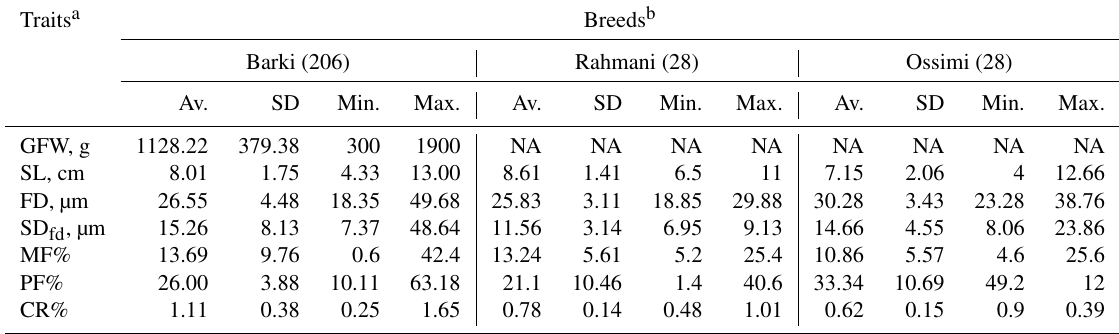
Table 1. Phenotypic characteristics of wool production traits in Egyptian sheep. Traits a Breeds b Barki (206) Rahmani (28) Ossimi (28) Av. SD Min. Max. Av. SD Min. Max. Av. Min. Max. GFW,